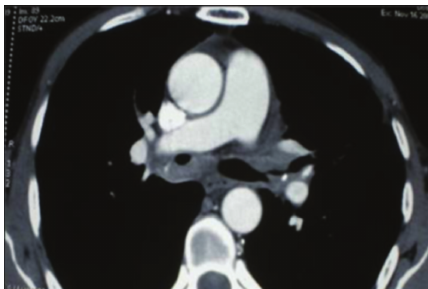
Figure 3: Computed tomography of the chest showing significant tracheobronchial wall thickening with narrowing of intermediate